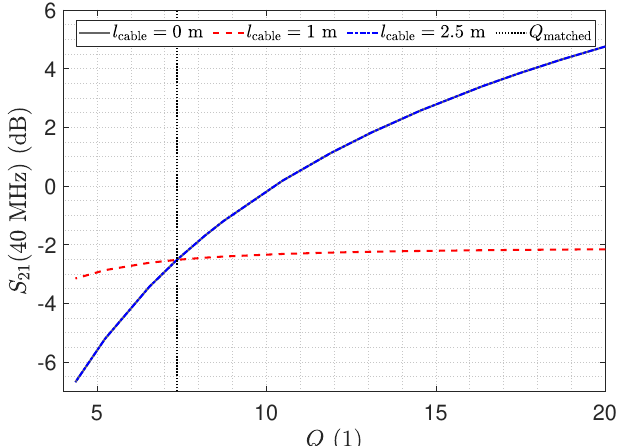
Figure 28. Transmission coefficient S 21 at 40MHz as a function of the LCR circuit quality factor determined by a SPICE simulation. Q matched denotes the quality factor of the matched LCR